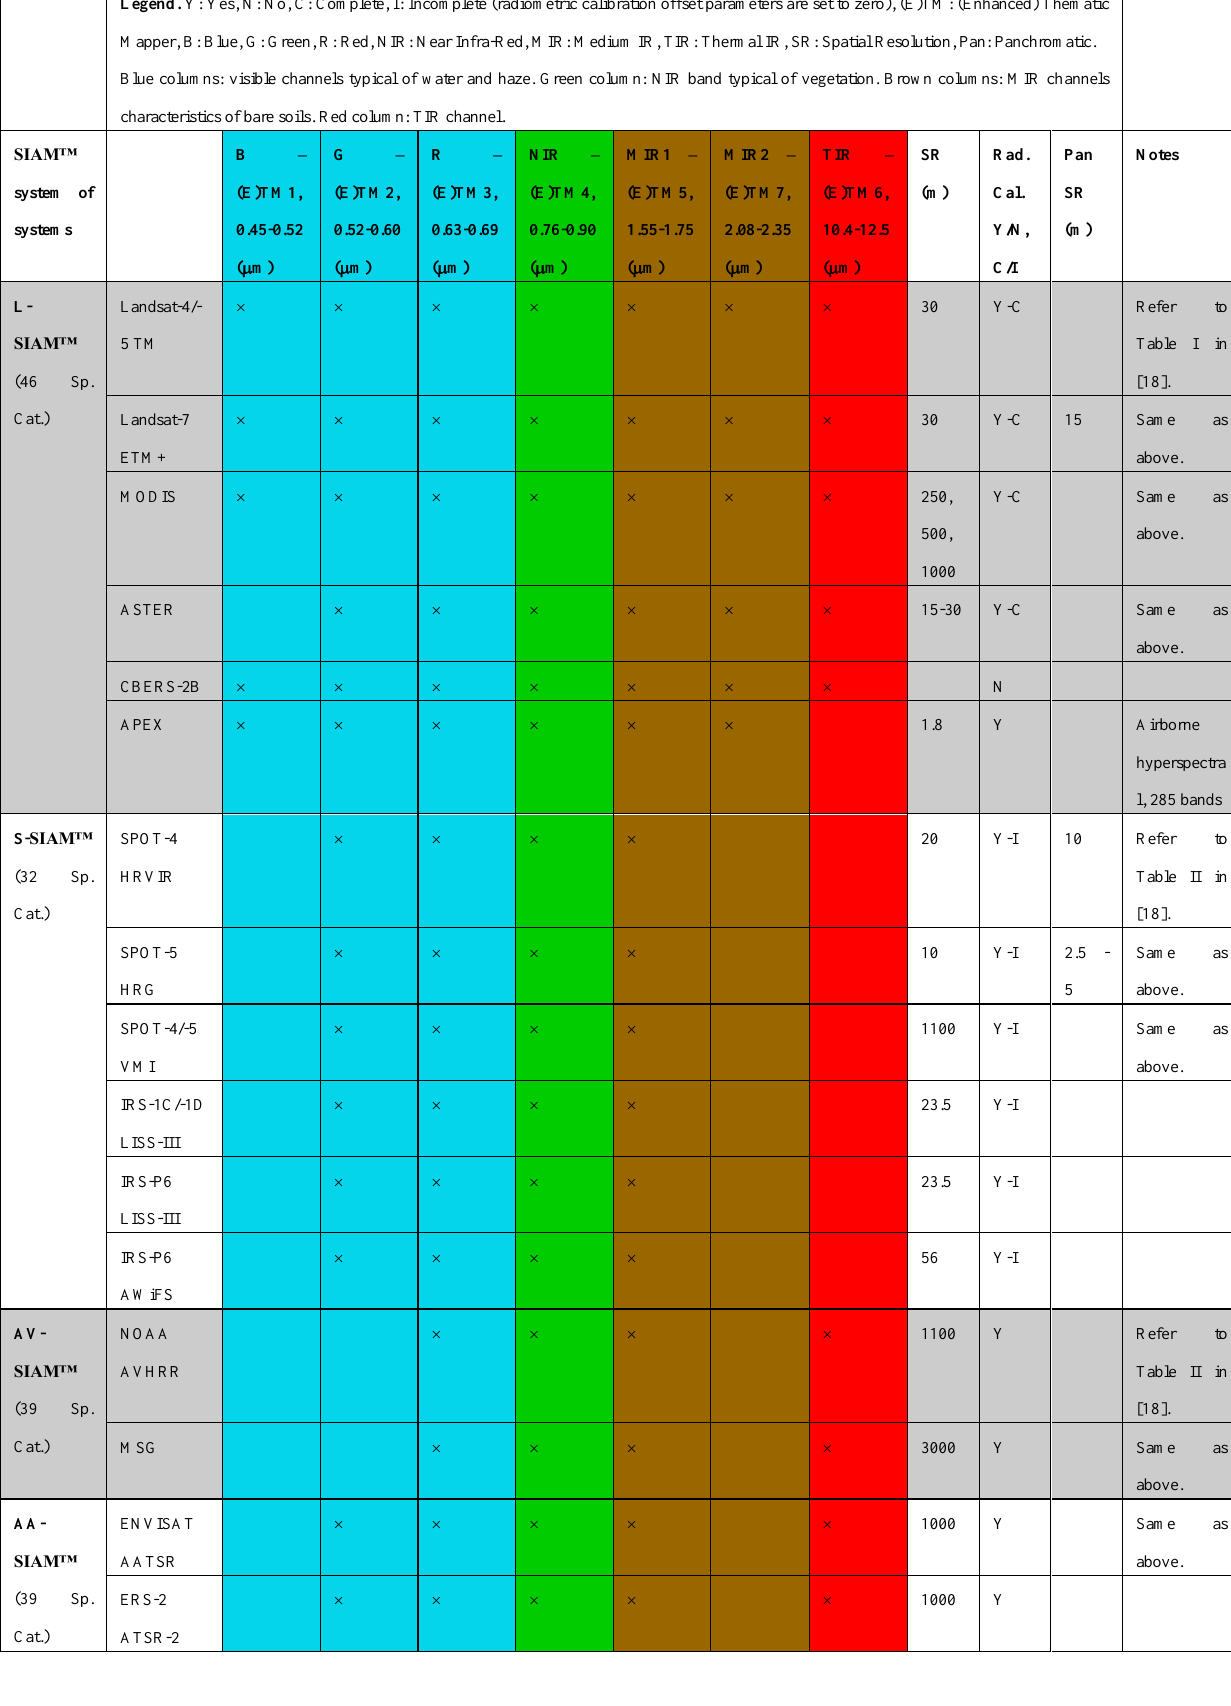
Table 1. Previously shown in [23]. SIAM™ system of systems: list of spaceborne imaging sensors eligible for